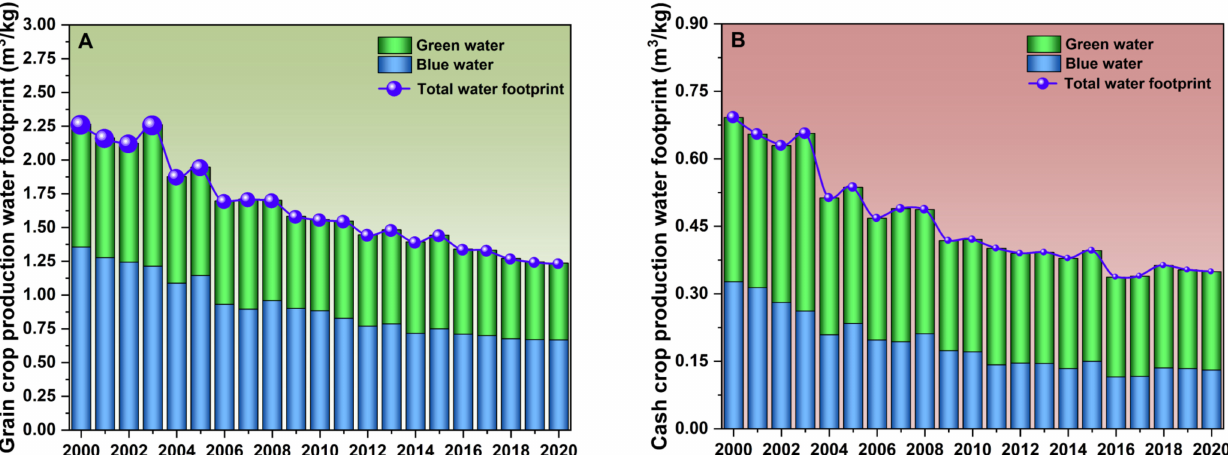
Figure 5. The evolution trend of the production water footprint of grains and cash crops over time. Note: ( A , B ) show the variation trends of the production water footprint of grain crop and cash crop over time,